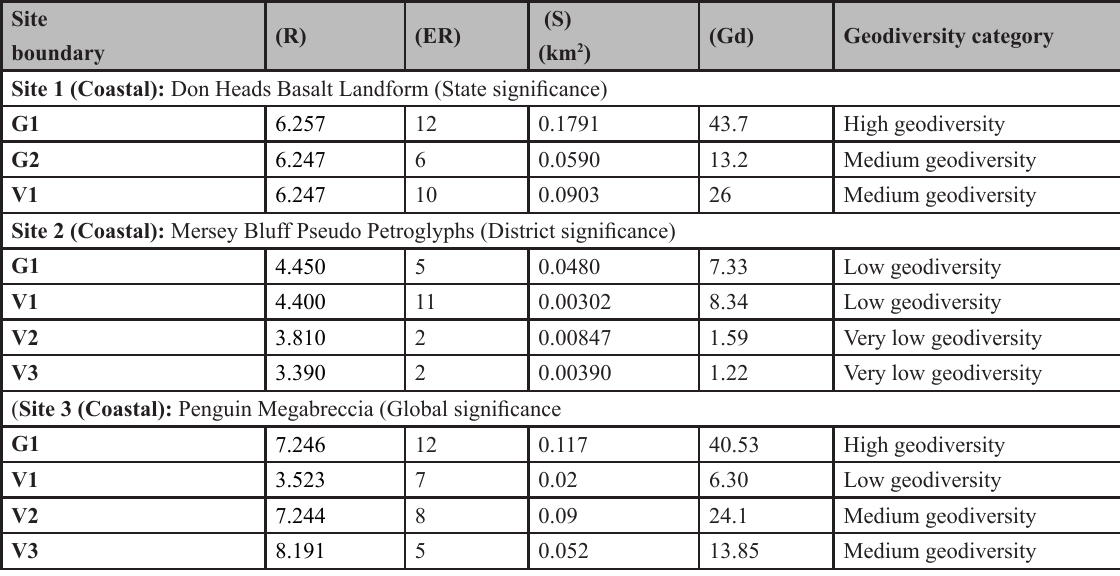
Table 4. The calculation of geodiversity within individual site boundaries from acquired field data using the